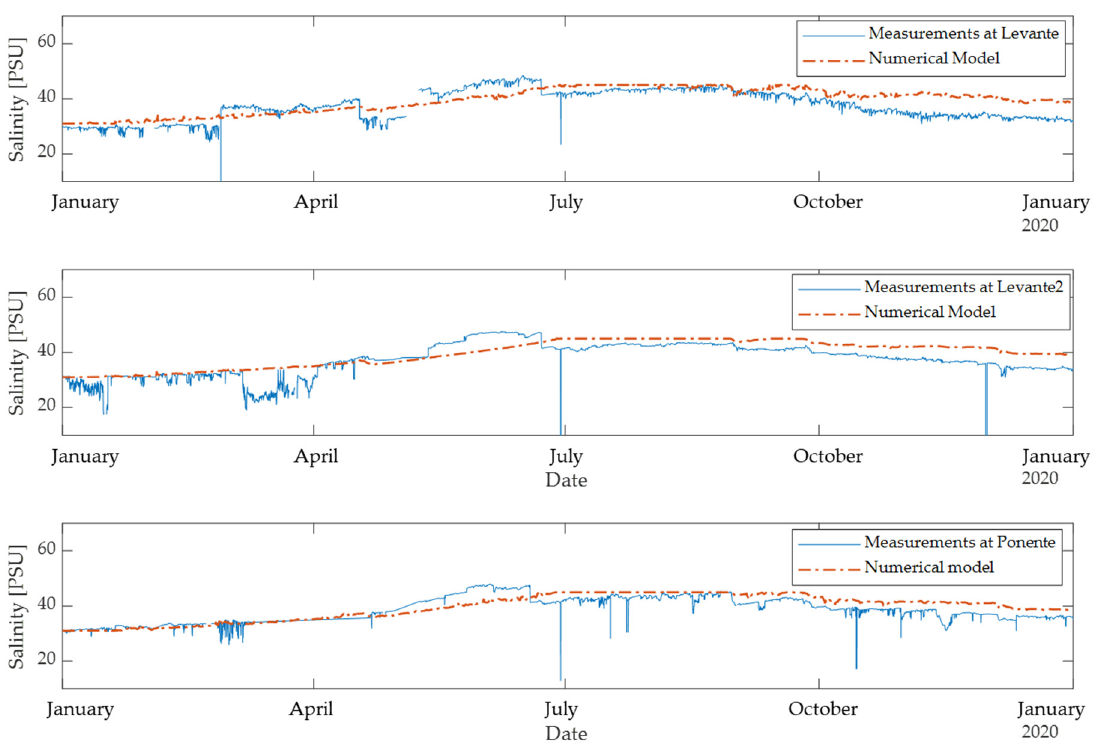
Figure 5. Comparison of time series of hourly temperature measured at the different monitoring station and simulated by the numerical model. From the top to the bottom, stations of Levante, Levante2, and Ponente.